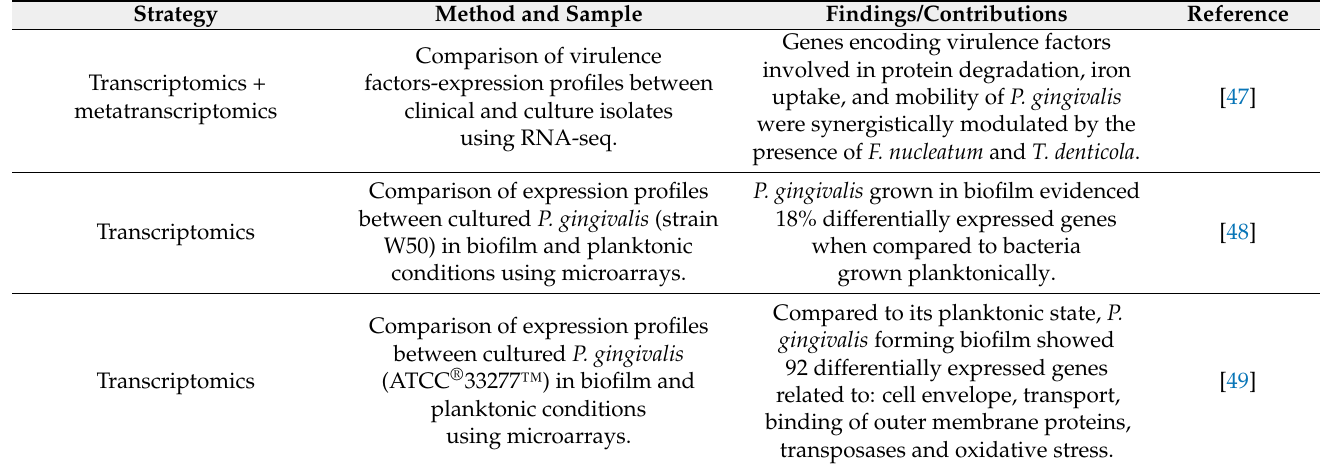
Table 2. Summary of Transcriptomics and metatranscriptomics research studies associated to this